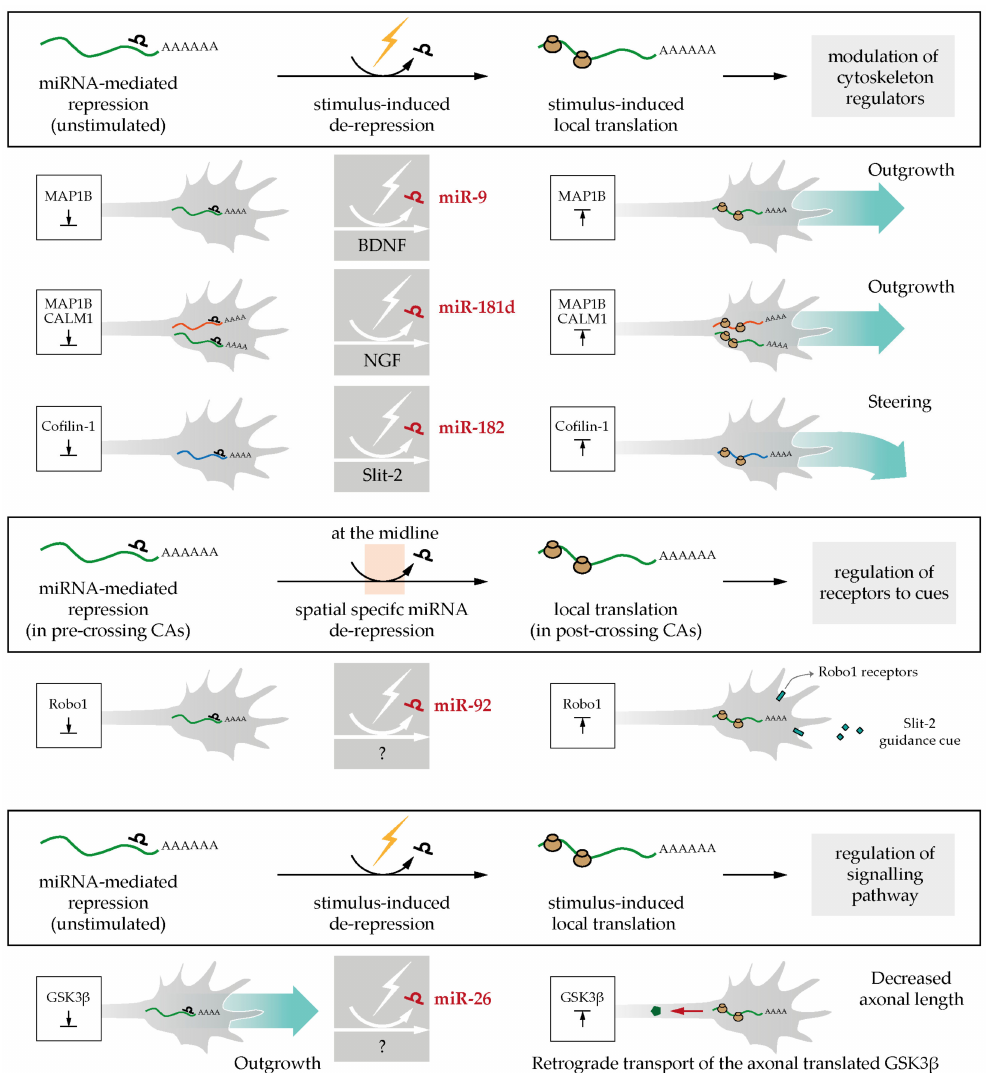
Figure 5. Axonal stimulations relieve miRNAs-mediated mRNAs silencing: role in axonal pathfinding. (i) brain-derived neurotrophic factor (BDNF), nerve growth factor (NGF) or Slit-2 stimulation induce miRNA de-repression and gate the translation of cytoskeleton regulators (MAP1B, CALM1, Cofilin-1) thereby regulating outgrowth and steering [41,52,73]; (ii) miR-92 keeps Robo1 silent in pre-crossing commissural axons (CAs), and miRNA de-repression at the midline triggers Robo1 translation and concomitant axon sensitivity to cue [75]; (iii) miR-26 de-repression in axons elicits glycogen synthase kinase-3 beta (GSK3 β ) local synthesis and this leads to the decrease in axonal outgrowth